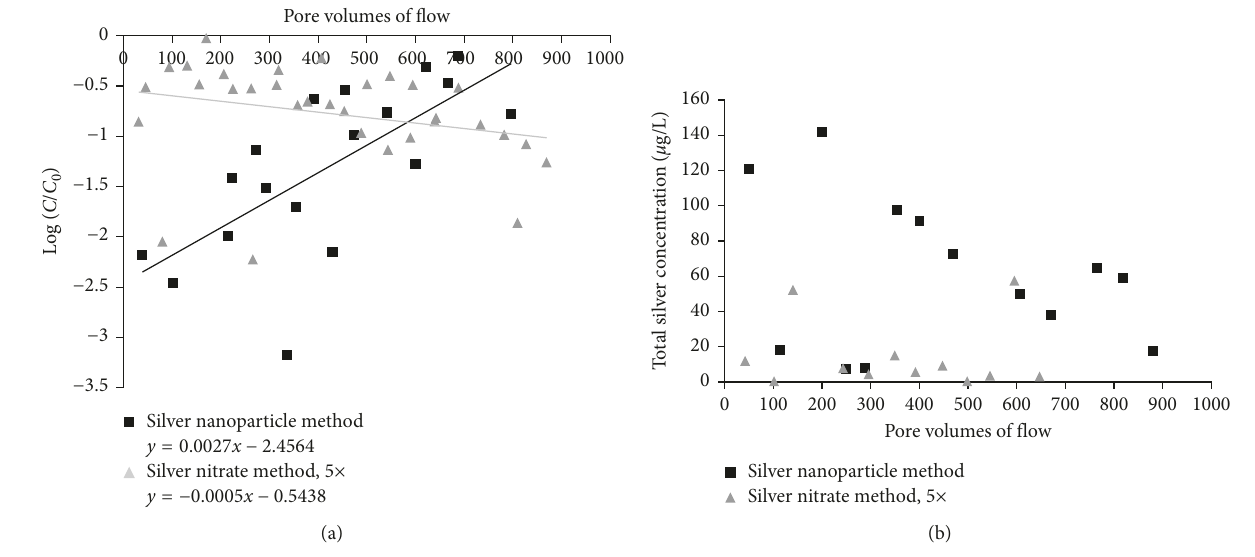
Figure 5: (a) Average log change of E. coli , Log ( C / C 0 ), versus pore volume of flow with a long-term constant exposure to E. coli by silver application method. Trend lines show the change in performance of E. coli removal over time. The slope of the trend line for the silver nanoparticle filters 0.0027 shows a decrease in performance. While the silver nitrate filter trend line has a slope of − 0.0005, meaning at least consistent performance. (b) Total silver concentration in effluent from silver-ceramic filter media as a function of pore volumes of flow with a long-term constant exposure to E. coli . Data are for two filter types with varying silver application methods and